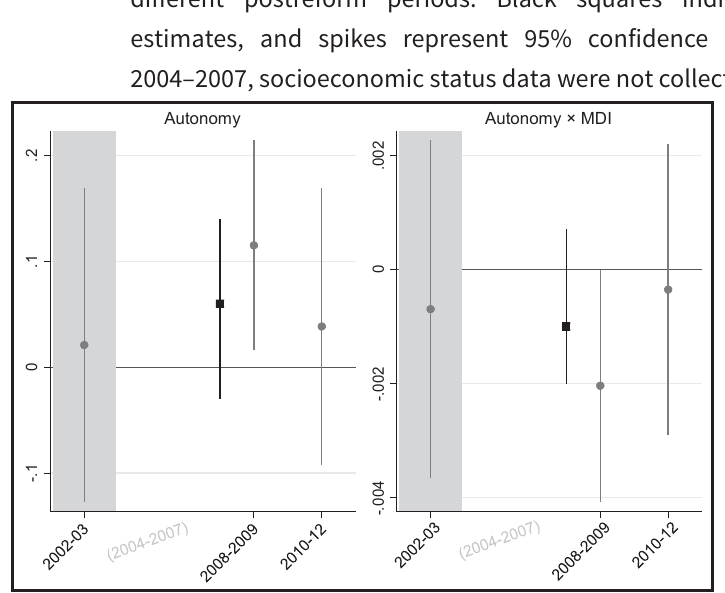
The effect of municipal autonomy on share of disadvantaged-background test takers. N otes: The figure plots the coefficients on municipal autonomy (left) and on the interaction between autonomy and development (right), estimated at different postreform periods. Black squares indicate over-time average estimates, and spikes represent 95% confidence intervals. In the period 2004–2007, socioeconomic status data were not